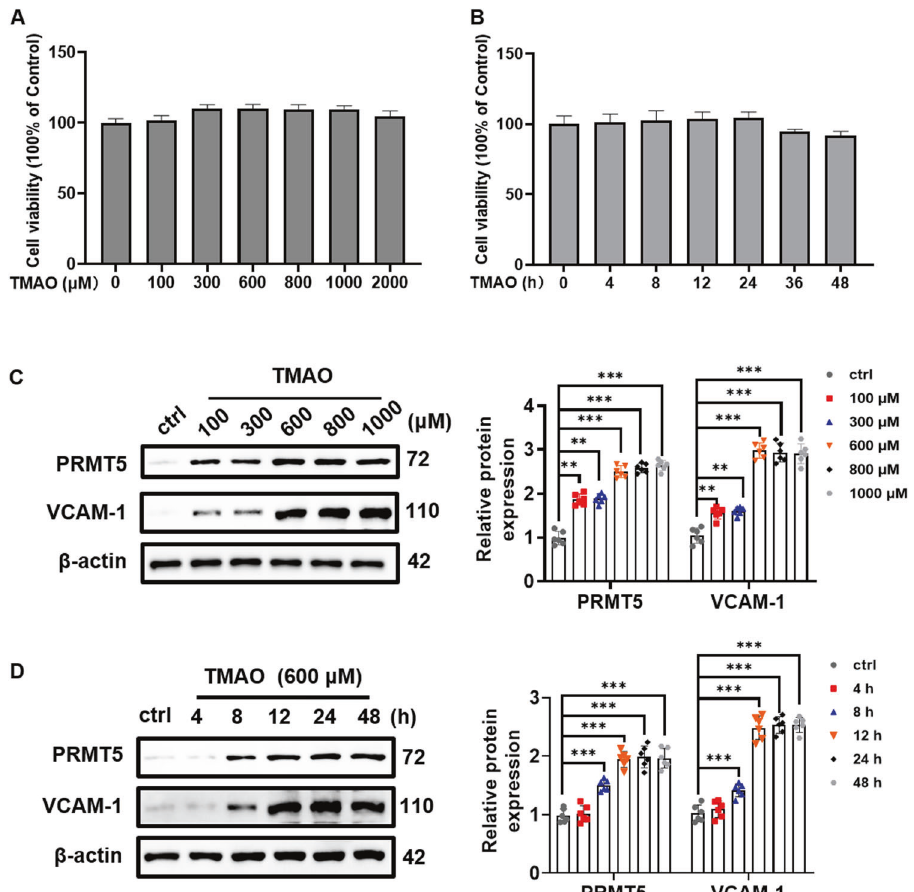
Fig. 1 TMAO upregulates PRMT5 and VCAM-1 expression in rat VSMC. A VSMC were treated with different concentrations of TMAO (100 – 2000 μ M) for 24 h. Subsequently, cell viability was determined using 3-(4, 5-dimethylthiazol-2-yl)-2, 5-diphenyl tetrazolium bromide (MTT) assay and quantitative analysis of cell viability. B VSMC were treated with TMAO (600 μ M) for indicated periods (4 – 48 h), and cell viability was detected using MTT assay and quantitative analysis of cell viability. C VSMC were treated for indicated concentrations of TMAO for 24 h. Representative blots and quantitative analysis of VCAM-1 and PRMT5. The protein expression level was normalized to β -actin. D VSMC were treated with TMAO (600 μ M) for indicated periods. Representative blots and quantitative analysis of VCAM-1 and PRMT5. The protein expression level was normalized to β -actin. Data shown are means ± SD, n = 6 per group from three independent experiments. ** P < 0.01, *** P < 0.001 using a one-way ANOVA followed by Tukey ’ s post hoc